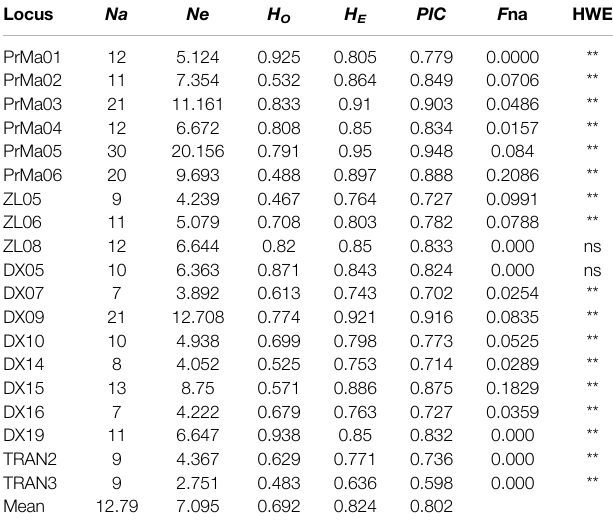
TABLE 3 | Genetic diversity parameters for 19 SSR loci.